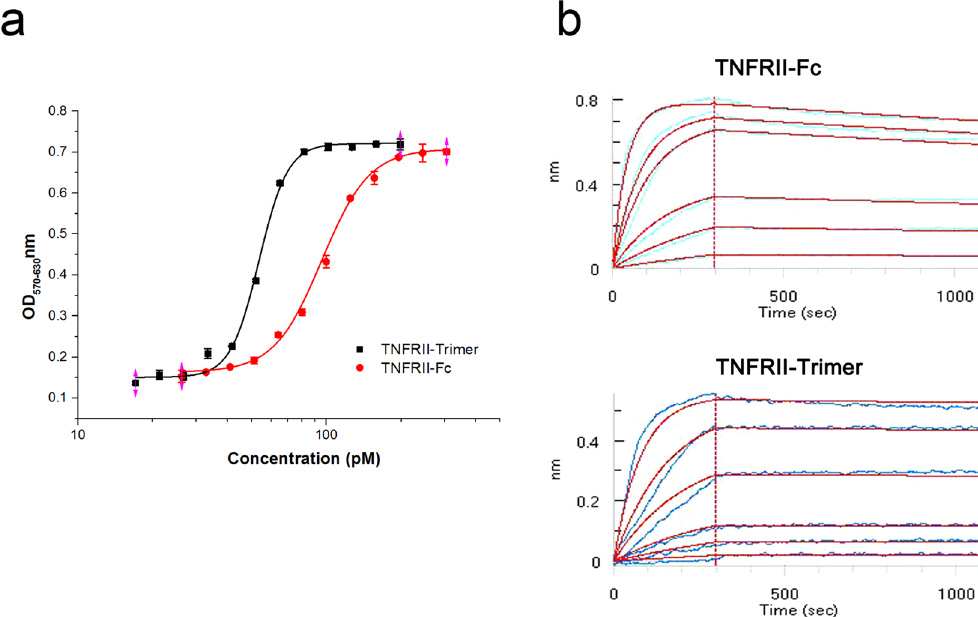
Figure 4. Bioactivity and affinity of TNFRII-Trimer and TNFRII-Fc to TNF- α . ( a ) Bioactivity detection of TNFRII-Trimer and TNFRII-Fc. Neutralizing TNF- α induced-cytotoxicity assays were performed using L929 cell line, and cell viability was evaluated using a colorimetric MTT assay. The IC 50 value of TNFRII-Trimer and TNFRII-Fc is 54pM and 98.6pM, respectively. ( b ) Ligand binding kinetics of TNFRII-Trimer and TNFRII-Fc binding to TNF- α were assessed by biolayer interferometry measurements. The Super Streptavidin biosensor tips of the ForteBio Octet RED 96 were coated with biotinylated TNFRII receptors. The biosensor tips were dipped in increasing concentrations gradient of the same molarity (2.5 nM–39 nM) to measure binding of TNFRII-Trimer and TNFRII-Fc to TNF- α and subsequently moved to wells containing buffer (PBS) to measure dissociation rates. Detailed results were shown in Table 2.